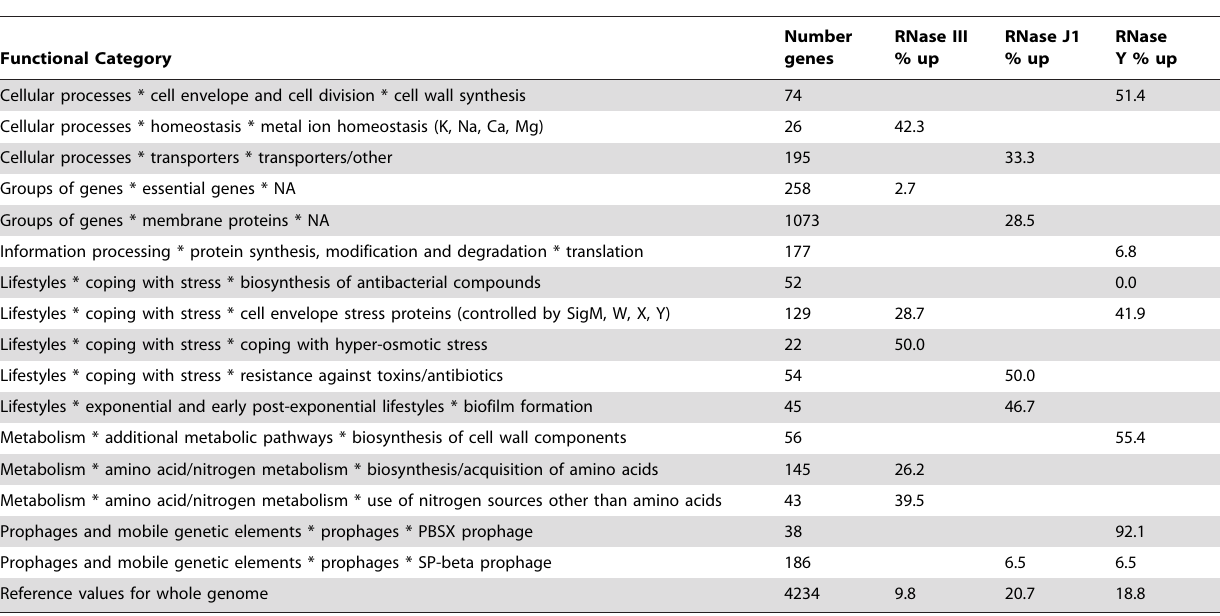
Table 1. Functional categories of mRNAs stabilised in RNase III, J1, and Y mutants.